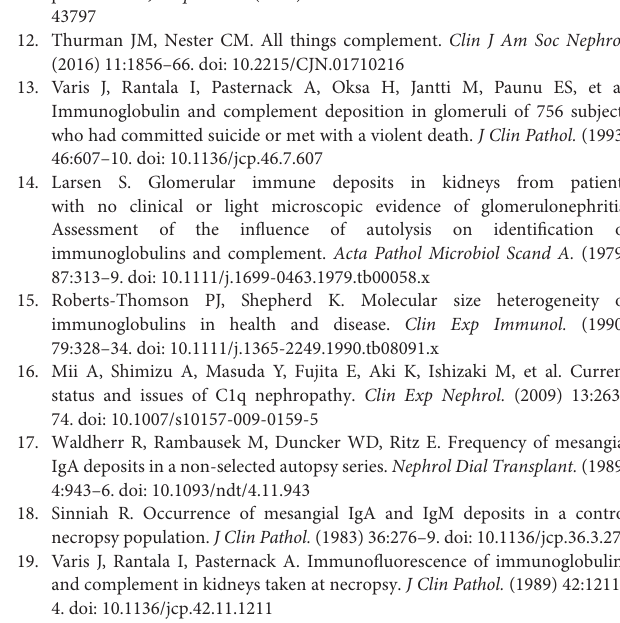
Supplementary Figure 1 | Ultrastructural findings in persisting immune reactivity in follow-up biopsies. In the left column examples of persisting immune reactivity in follow-up biopsies are shown as indicated. The right column shows the corresponding ultrastructural findings with osmiophilic deposits indicated by arrows, which in the lower panel were very small. All light microscopic pictures were taken at an original magnification of 400x. Scale bars indicate 100 µ m. Ultrastructural micrographs all in 5,000x original